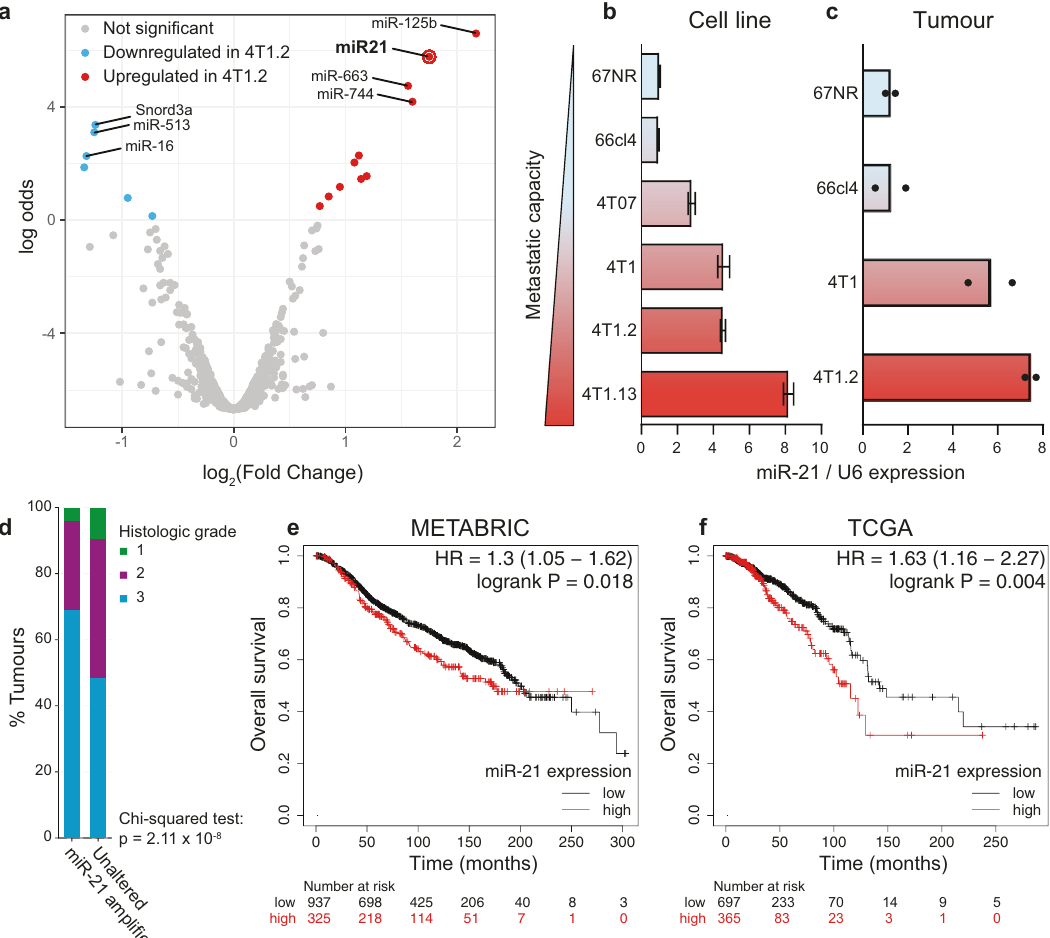
Fig. 1 miR-21 is associated with metastatic capacity of breast cancer and predicts poor clinical outcome. a Volcano plot of differentially expressed miRNAs between non-metastatic 67NR and highly metastatic 4T1.2 mouse mammary tumour cells. b , c Expression of mature miR- 21 levels in mouse mammary tumour cells ( b ) and in whole tumours ( c ) derived from the 4T1 model, with varying levels of metastatic capacity. MiR-21 expression was normalised to expression of Rnu6 small nuclear RNA (U6) and set to 1 in the non-metastatic 67NR line. Error bars in ( b ) represent mean ± SEM ( n = 3). The mean and range ( n = 2) is shown in ( c ). d The miR-21 gene at 17q23 is ampli fi ed in a subset of primary human breast cancers and is associated with higher tumour grade compared to non-ampli fi ed tumours ( p = 2.11 ×10 − 8 ). e , f Higher levels of miR-21 expression in primary breast tumours are associated with poorer overall survival in the Metabric ( n = 1262) and the TCGA ( n = 1078) breast cancer patient Analysis of components of the innate immune system revealed no change in the overall number of neutrophils (Fig. 4f). However, reduced miR-21 activity led to diminished monocyte in fi ltration (Fig. 4g, j), particularly in Ly6C hi in fl ammatory monocytes, with reduced numbers of Ly6C hi but not Ly6C lo monocytes expressing CD206, a marker of an M2-like polarisation state (Fig. 4h, k). In parallel, there were reduced numbers of both Ly6C hi and Ly6C lo monocytes expressing PD-L1 (Fig. 4i, l). There was no signi fi cant change in total natural killer (NK) cells, nor in their activation state as measured by CD69 + expression (Fig. S4a – c). The combination of an enhanced adaptive immune response and a reduction in PD- L1 + monocytes could explain the potent suppression of 4T1.13 tumour growth when miR-21 activity is reduced (Fig. 3c). A similar analysis of the immune in fi ltrate of 66cl4 mammary tumours with or without enforced expression of miR-21 was completed. Tumours were recovered prior to miR-21-induced changes in growth rate (Fig. S6a, b). A trend towards decreased CD45 + cells was found (Fig. S6c), but no signi fi cant differences were